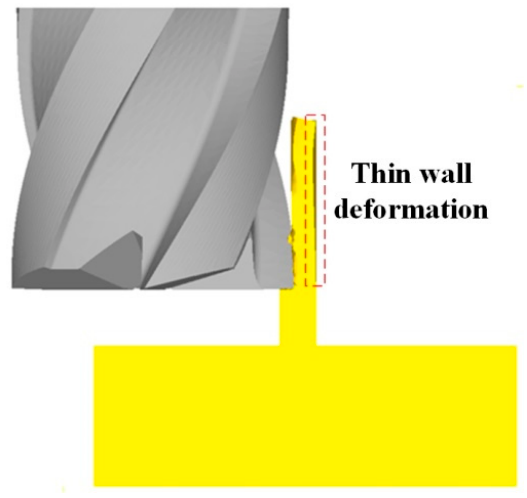
Figure 7. Thin wall deformation in simulation process.